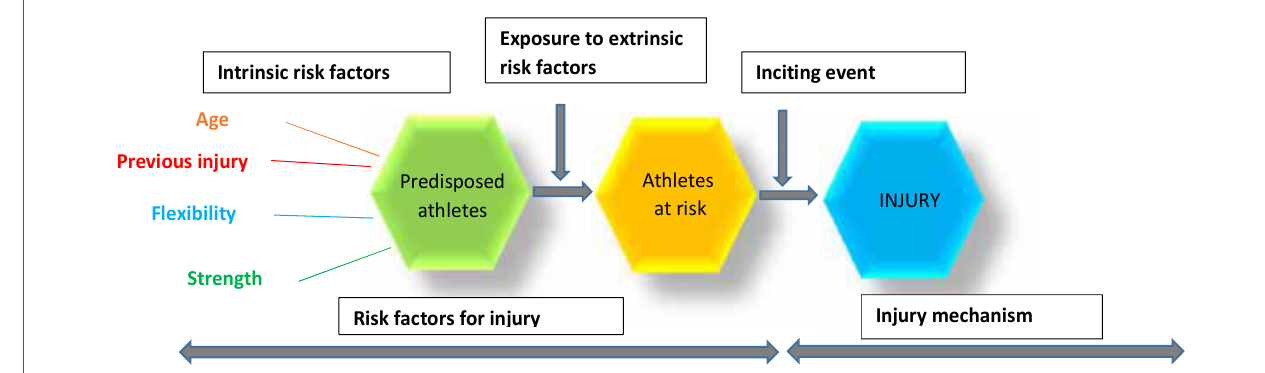
Figure 2: Risk factors of sports injuries